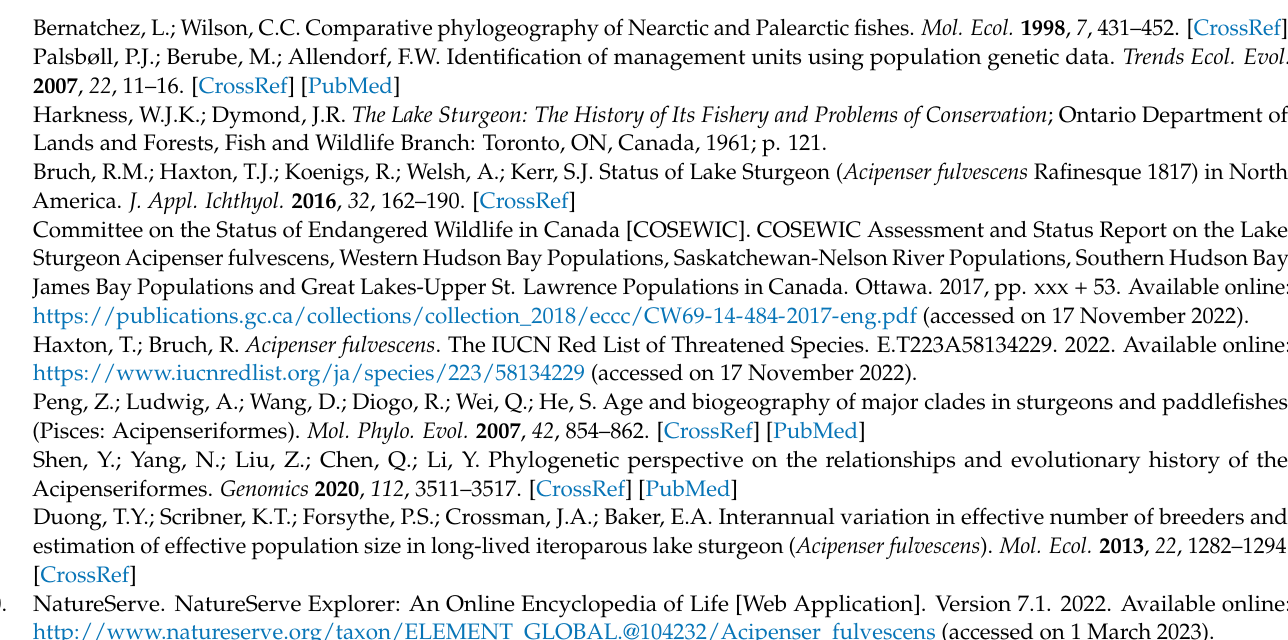
Table S2: Linkage disequilibrium tests for locus pairs within and among populations; Table S3: F IS values for individual loci within populations; Table S4: Pairwise divergence estimates among populations, showing F ST estimates below diagonal and Jost’s D above